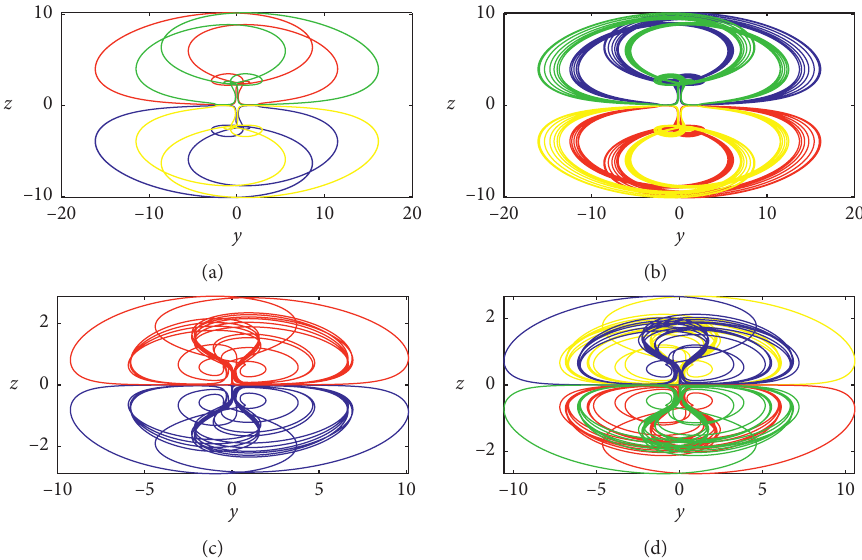
Figure 6: Coexisting attractors in the memristive hyperchaotic system: projections of different attractors on the y − z plane for different initial conditions. (a) Symmetric period-1, [ 1 , 1 , 1 , 1 , 1 , 1 ] (red), [− 1 , − 1 , − 1 , 1 , 1 , 1 ] (blue), [− 1 , − 1 , 1 , 1 , − 1 , − 1 ] (green), and [ 1 , 1 , − 1 , − 1 , − 1 , 1 ] (yellow). (b) Symmetric one-wing multiperiod, [− 1 , 1 , 1 , − 1 , 1 , 1 ] (red), [ 1 , 1 , − 1 , 1 , 1 , 1 ] (blue), [− 1 , − 1 , − 1 , 1 , − 1 , − 1 ] (green), and [ 1 , − 1 , 1 , − 1 , − 1 , − 1 ] (yellow). (c) Symmetric two-wing multiperiod, [− 1 , 1 , 1 , 1 , 1 , 1 ] (red) and [ 1 , 1 , − 1 , − 1 , 1 , 1 ] (blue). (d) Symmetric two-wing multiperiod, [− 1 , 1 , − 1 , 1 , − 1 , − 1 ] (red), [− 1 , − 1 , 1 , − 1 , 1 , 1 ] (blue), [ 1 , − 1 , − 1 , 1 , 1 , 1 ] (green), and [ 1 , 1 , 1 , − 1 , − 1 , − 1 ]